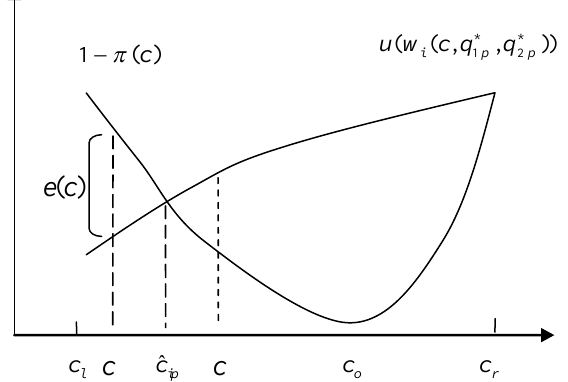
Fig. 2. Graphical explanation of the procedure for obtaining c ˆ ip